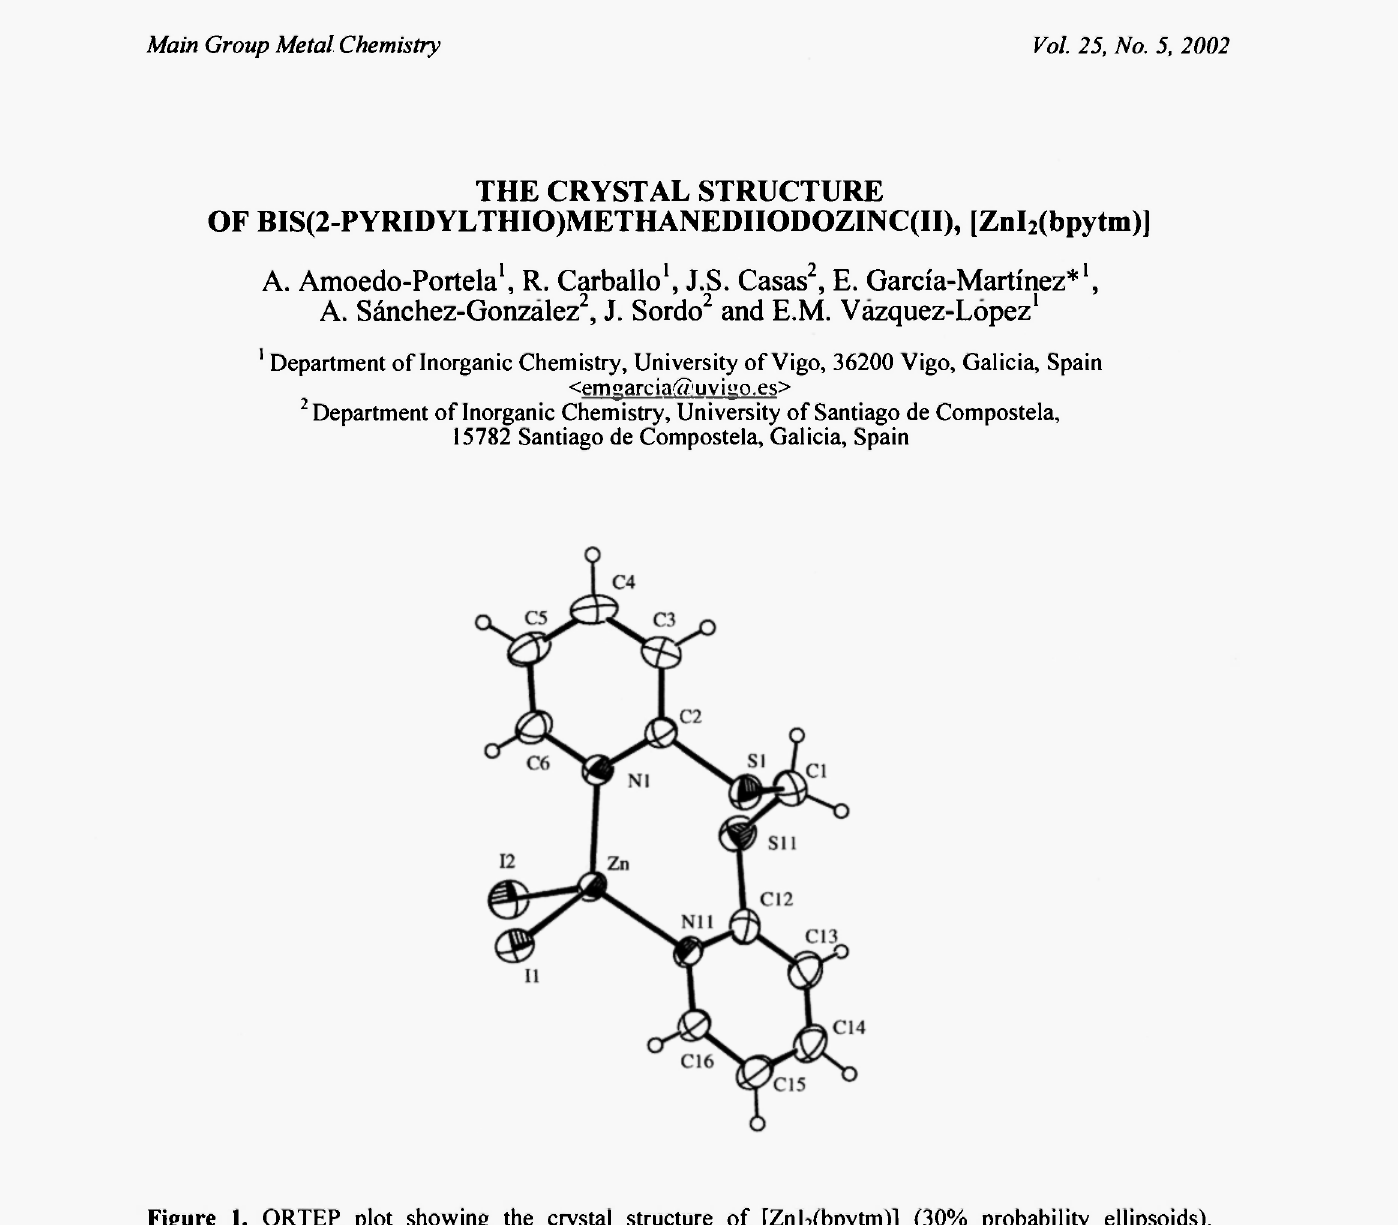
Figure 1. ORTEP plot showing the crystal structure of [Znl->(bpytm)] (30% probability ellipsoids). Selected bond lengths (Ä) and angles (°): Zn-N(l), 2.060(4); Zn-N(ll), 2.061(4); Zn-I(l), 2.6045(7); Zn- 1(2), 2.5773(7); N(l)-Zn-N(11), 122.87(16); N(l)-Zn-I(2), 107.06(11); N(11)-Zn-I(2), 107.04(11); N(l)- Zn-I(l), 102.63(11); N(1 l)-Zn-I(l), 107.78(13); I(l)-Zn-I(2),